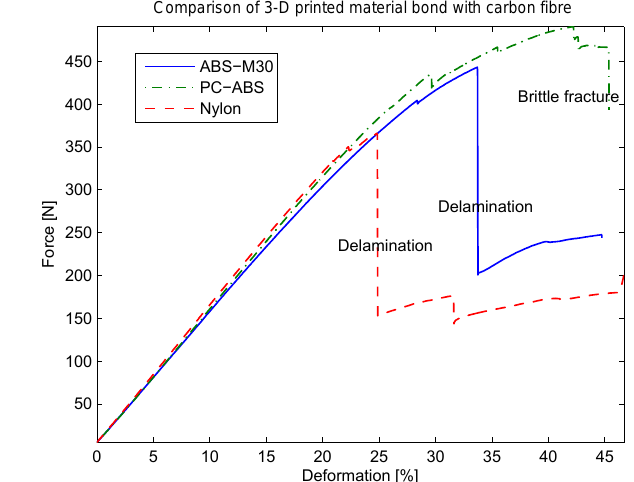
Figure 5. Calculated stiffness characteristics compared with mea- sured stiffness